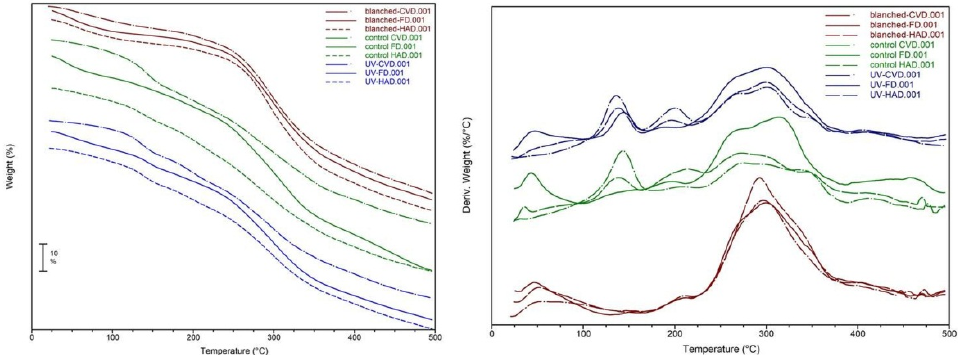
Figure 8. TG and DTG curves of B. edulis mushrooms subjected to different pretreatment and drying methods for the temperature range of 25–500 °C. The characteristics of the TG analysis of mushroom powders are illustrated in Table 4. Table 4. Results of TG investigation of B. edulis mushrooms subjected to different pretreatment and drying methods.